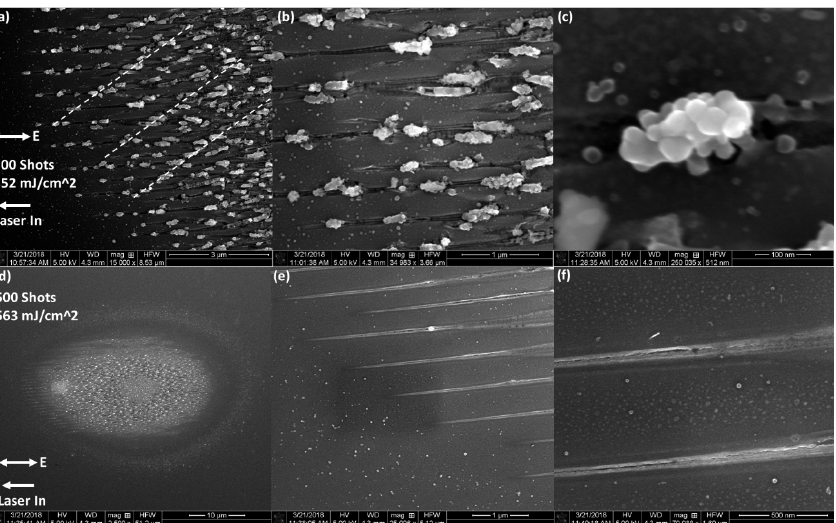
Figure 6. SEM images of multi-shot LID on silicon (100) with 500 shots. The laser input direction and polarization direction are indicated as projected onto the sample plane. The fluence is indicated on the bottom left for figures ( a – c ) and for figures ( d – f ); ( a – c ) show a damage site with progressively increasing magnification. The white dotted lines in ( a ) overlay ordering along a diagonal; ( d – f ) show a higher fluence damage site; ( d , f ) show increased magnification of the peripheral nano-trenches in ( d